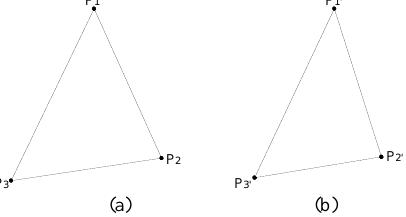
Fig. 1. Primitive deformation (dominant deformation) in triangles. (a) the triangle before deformation, (b) the triangle after